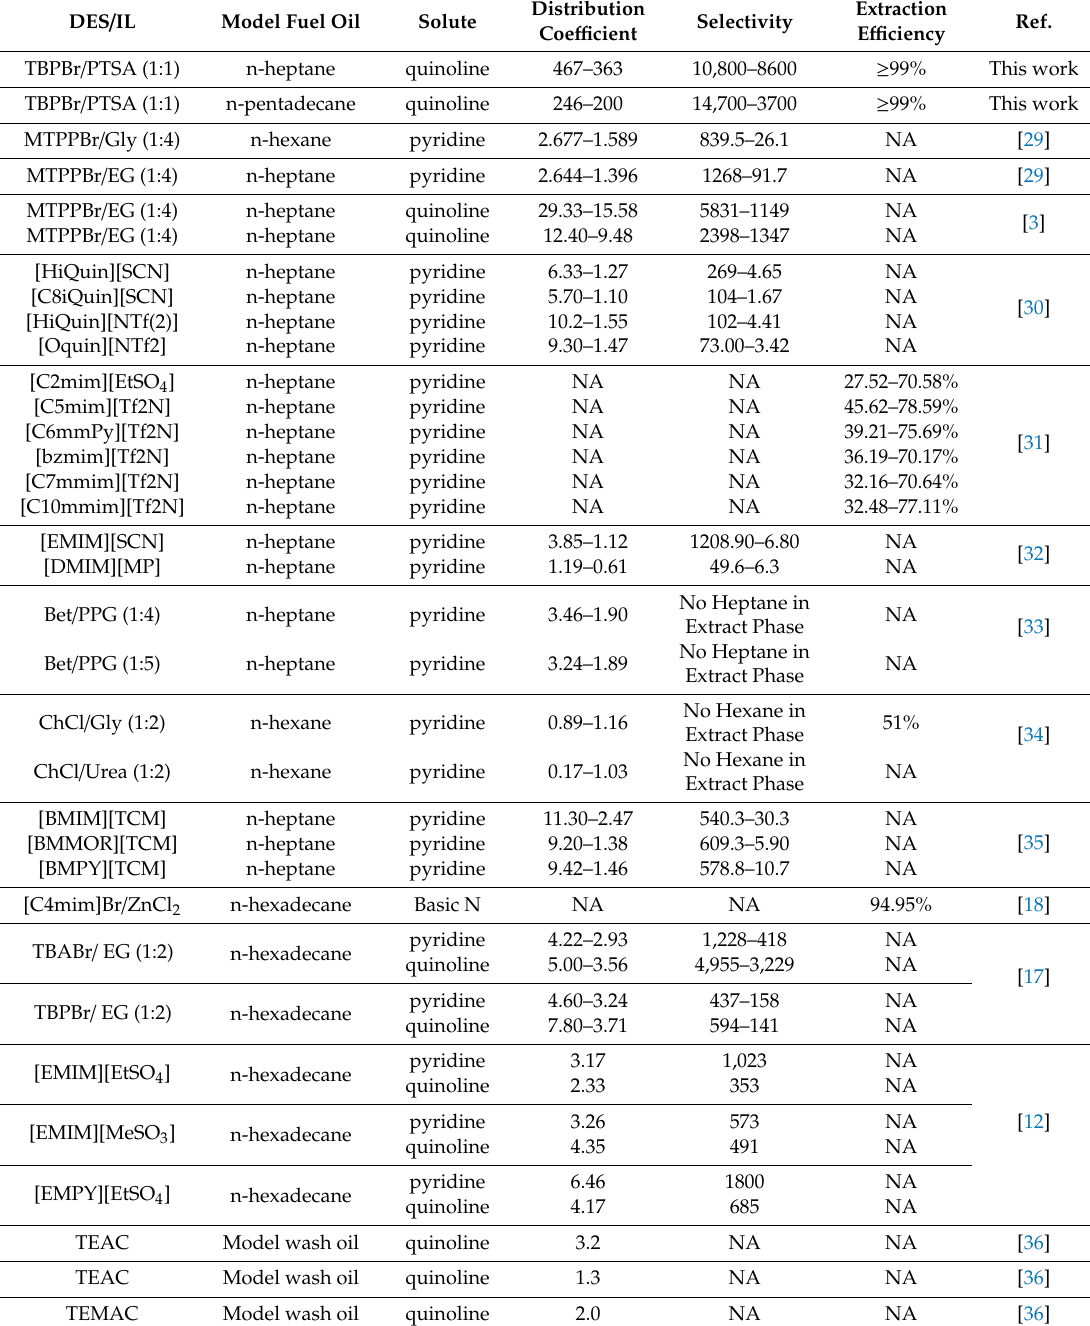
Table 9. Experimental data on the use of ionic liquids (ILs) and DESs for extractive denitrogenation from heptane and